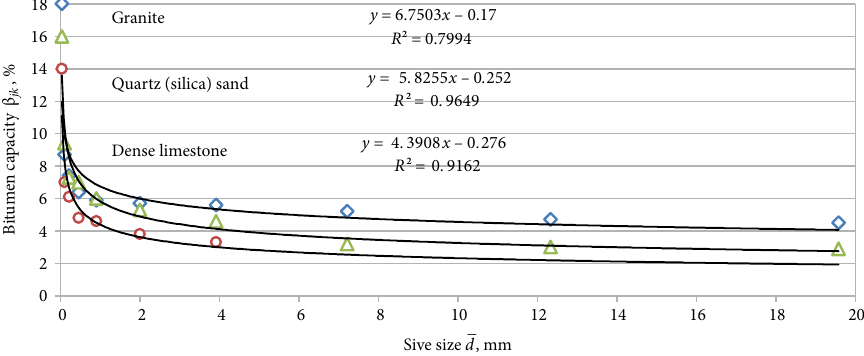
y = 6.7503 x – 0.17 R ² = 0.7994 y = 5.8255 x – 0.252 R ² = y = 4.3908 x – 0.276 R ² = 0.9162